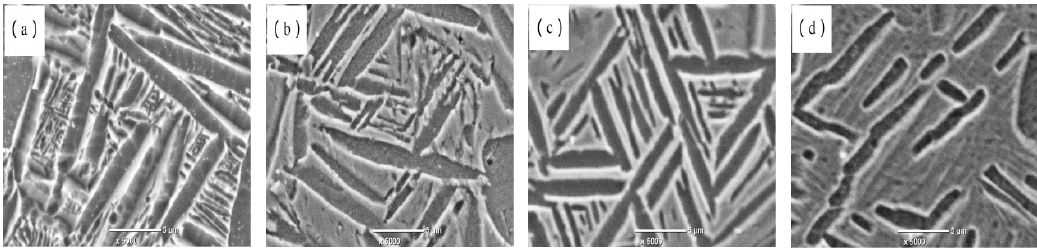
Figure 6. Secondary electron images of the lamellar α with initially microstructure III: ( a ) 800 °C, WQ; ( b ) 860 °C, WQ; ( c ) 900 °C, WQ; ( d ) 970 °C, WQ.